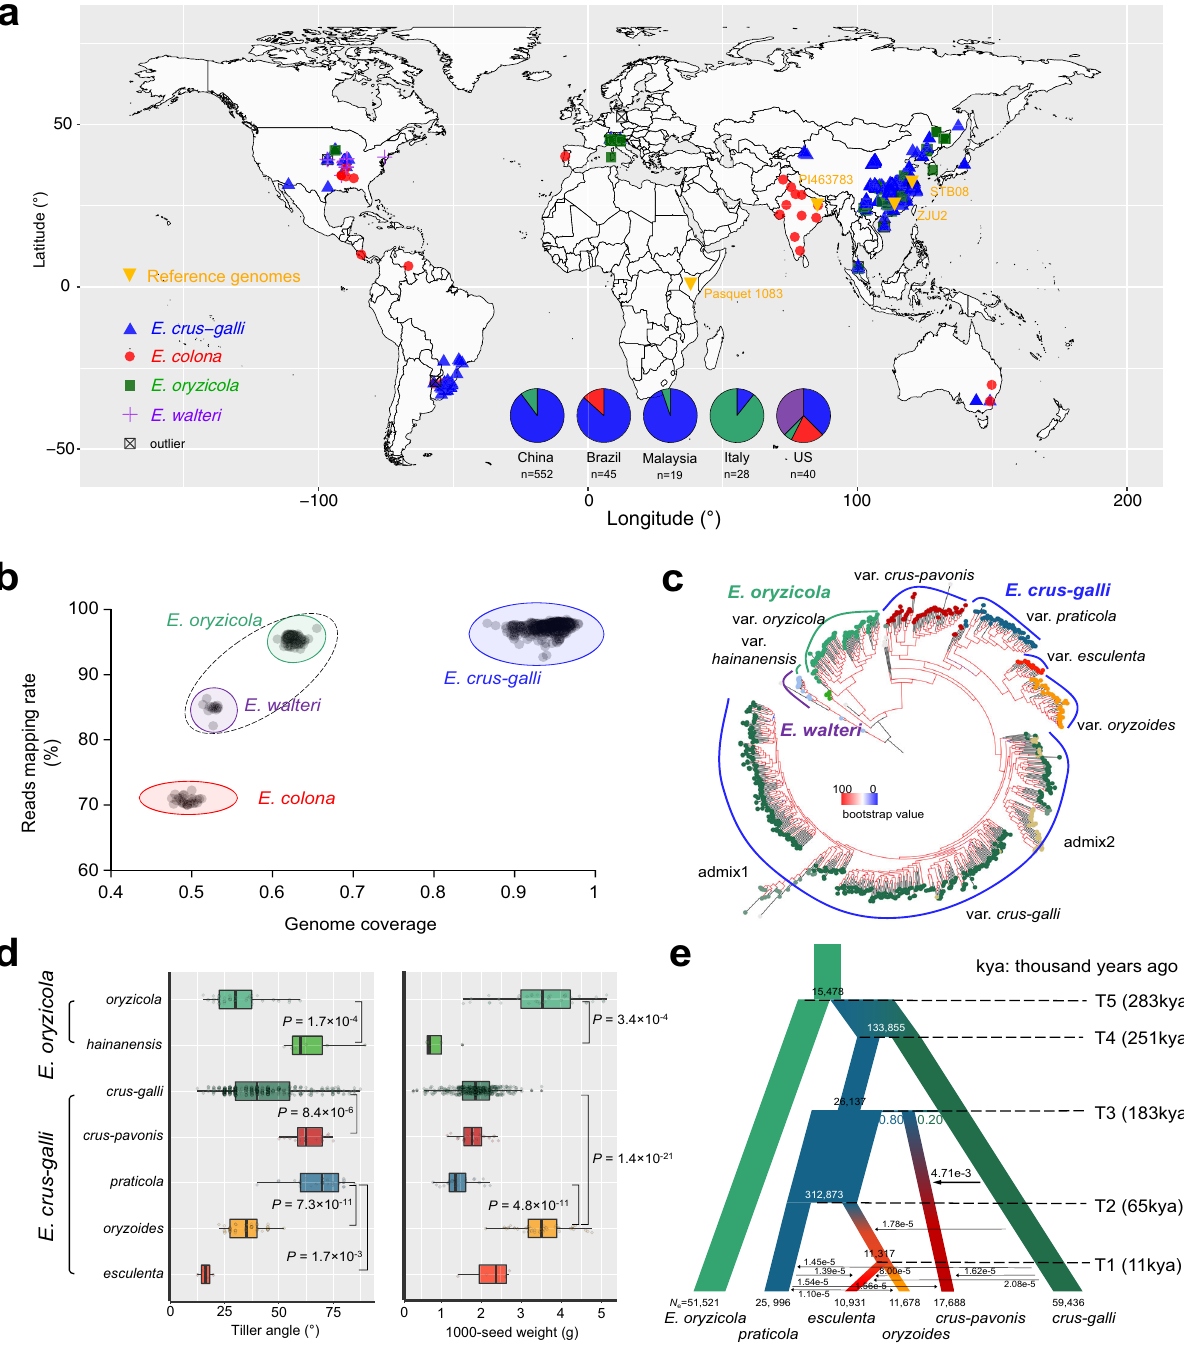
Fig. 2 Population structure and demography of Echinochloa species. a Global distribution of the Echinochloa plants used in this study. The locations of the four Echinochloa accessions with sequenced reference genomes are indicated by yellow downward triangles. The species distributions of the Echinochloa accessions sampled from fi ve countries (China, Brazil, Malaysia, Italy, and United States) are shown in pie charts. b Four Echinochloa species are identi fi ed based on mapping rates and genome coverage of reads mapped to the E. crus-galli reference assembly (STB08). c The maximum-likelihood phylogeny of E. crus-galli and E. oryzicola accessions are inferred using genome-wide non-synonymous single nucleotide polymorphisms (SNPs), with tetraploid E. walteri as an outgroup species. d Phenotypic differences (tiller angle and 1000-seed weight) in the varieties of E. oryzicola and E. crus-galli (accession number: n = 38 oryzicola , n = 6 hainanensis , n = 321 crus-galli , n = 15 crus-pavonis , n = 25 praticola , n = 38 oryzoides , n = 4 esculenta ). In the box plots, the horizontal line shows the median value, and the whiskers show the 25% and 75% quartile values of tiller angles and seed weights. P values are calculated using the two- tailed Wilcoxon test. e Demographic history of E. crus-galli varieties. T1 to T5 indicate the estimated time of population divergence. N e , effective population size. Kya, thousand years ago. Source data are provided as a Source data fi